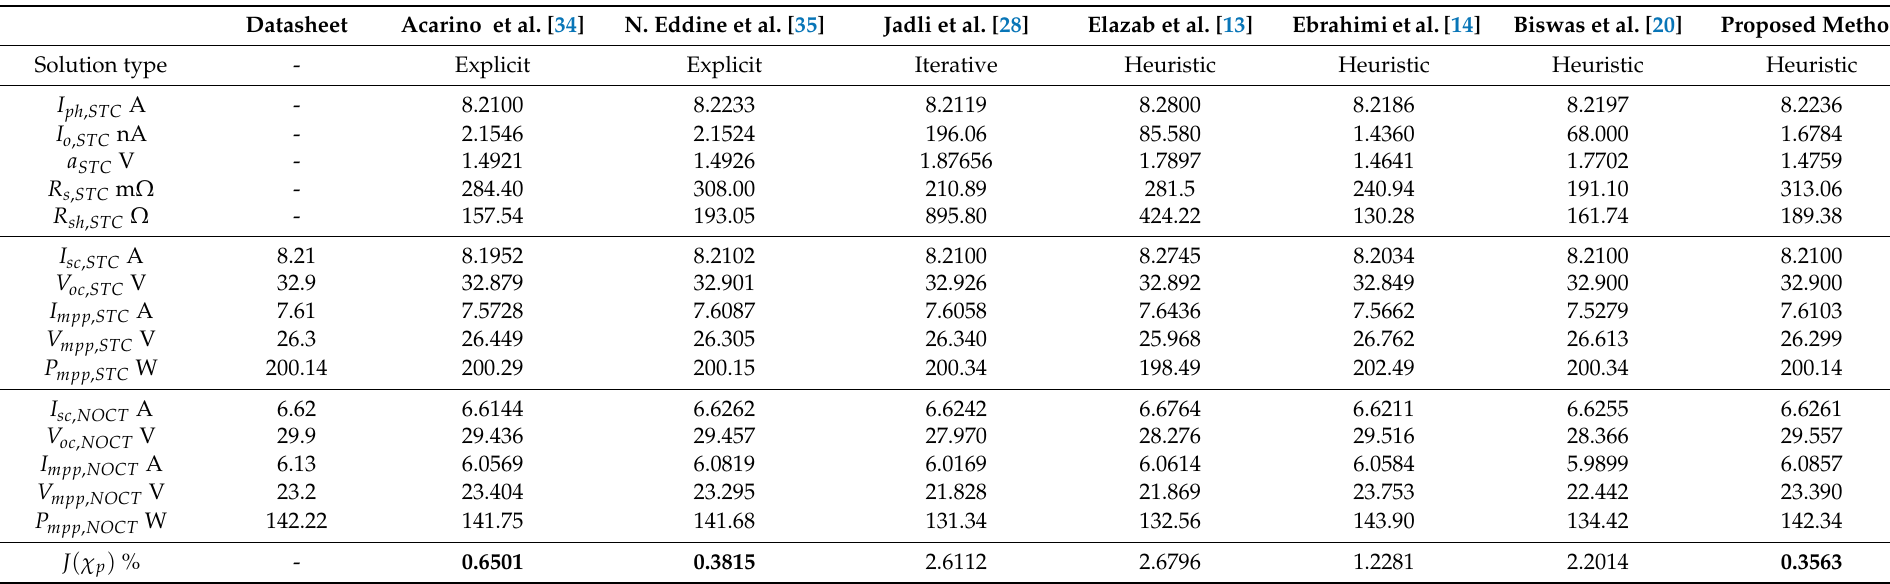
Table 3. Error of the calculated parameters for the Kyocera KC200GT SPVM. The table displays the cardinal points at the STC and NOCT